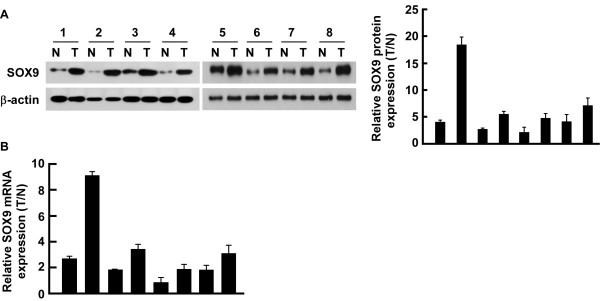
Differential expression of SOX9 in human NSCLC tissues (T) and their paired normal lung tissue (N), each pair obtained from the same patient. A, Western blotting analysis of SOX9 protein expression in eight paired tumor and normal tissue samples, average tumor/normal ratios of SOX9 protein expression quantified using the LabWorks software. Expression levels were normalized with β-actin. B, average tumor/normal ratios of SOX9 expression were quantified by real-time RT-PCR. Expression levels were normalized for GAPDH. Bars, SD from three independent experiments